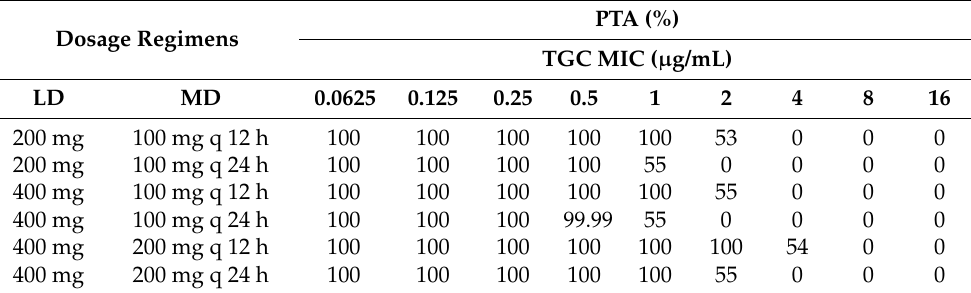
Table 4. The probability of target attainment (PTA) for the different tigecycline regimens in critically ill patients at steady state with targets of f AUC24/MIC ≥